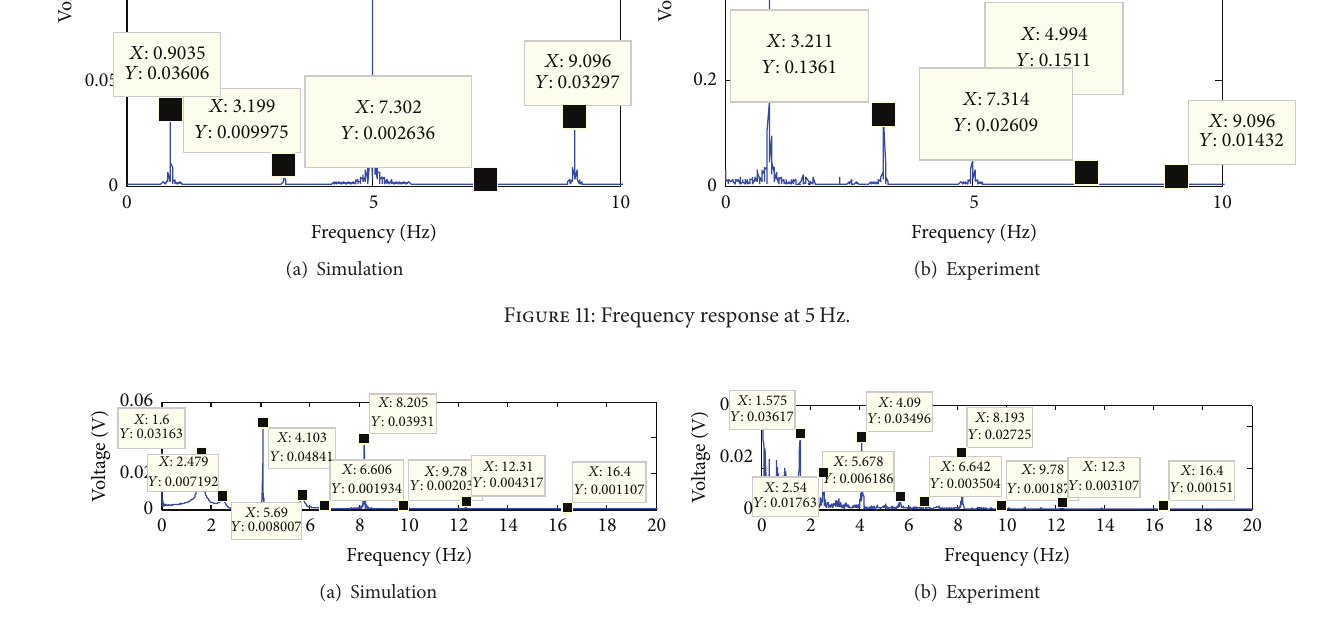
Figure 12: Frequency response at 8.2